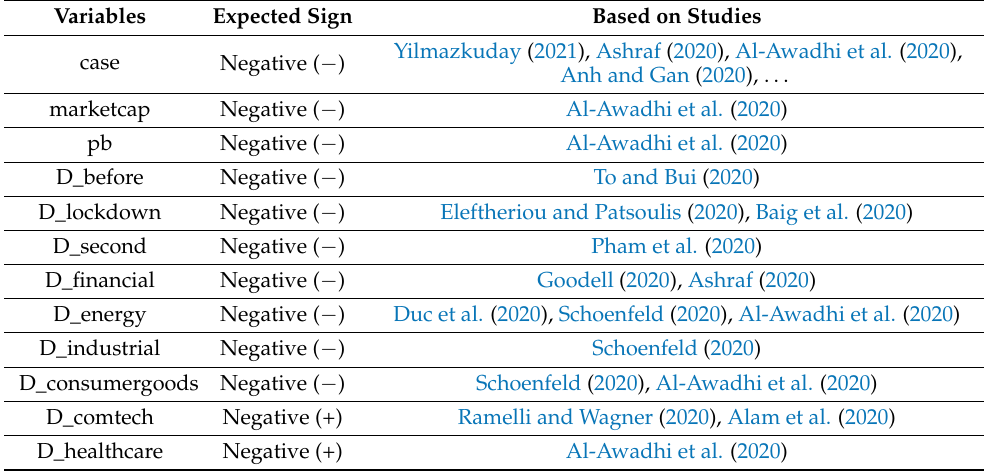
Table 1. Hypotheses with expected signs of relationships based on previous